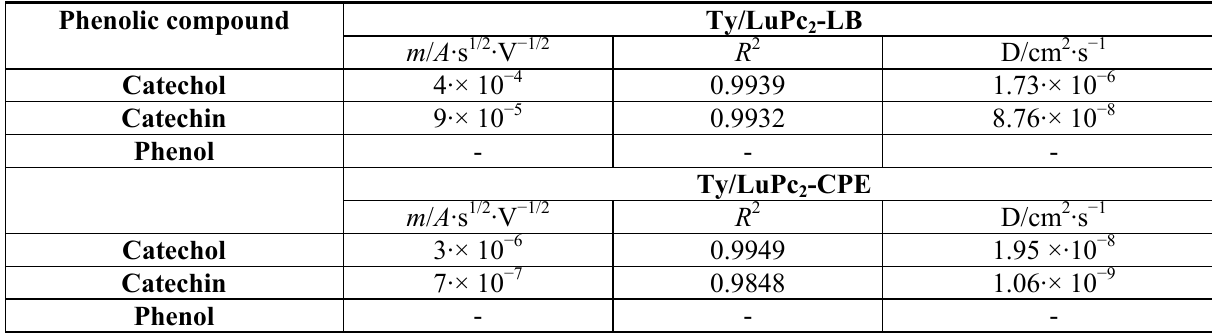
Table 2. Quantitative data obtained from influence of scan rate in biosensors response studies applied to the anodic peak at 0.4